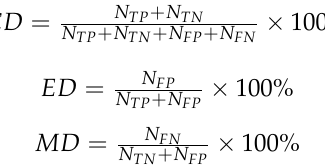
Table 4. Quantitative ablation results of the different domain adaptation architecture. CD